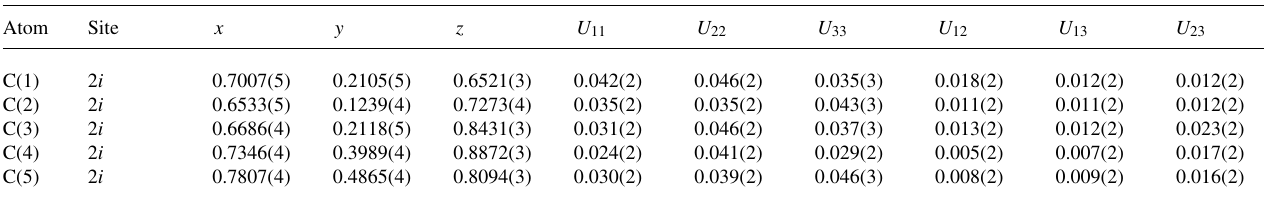
Table 3. Atomic coordinates and displacement parameters (in Å 2 )